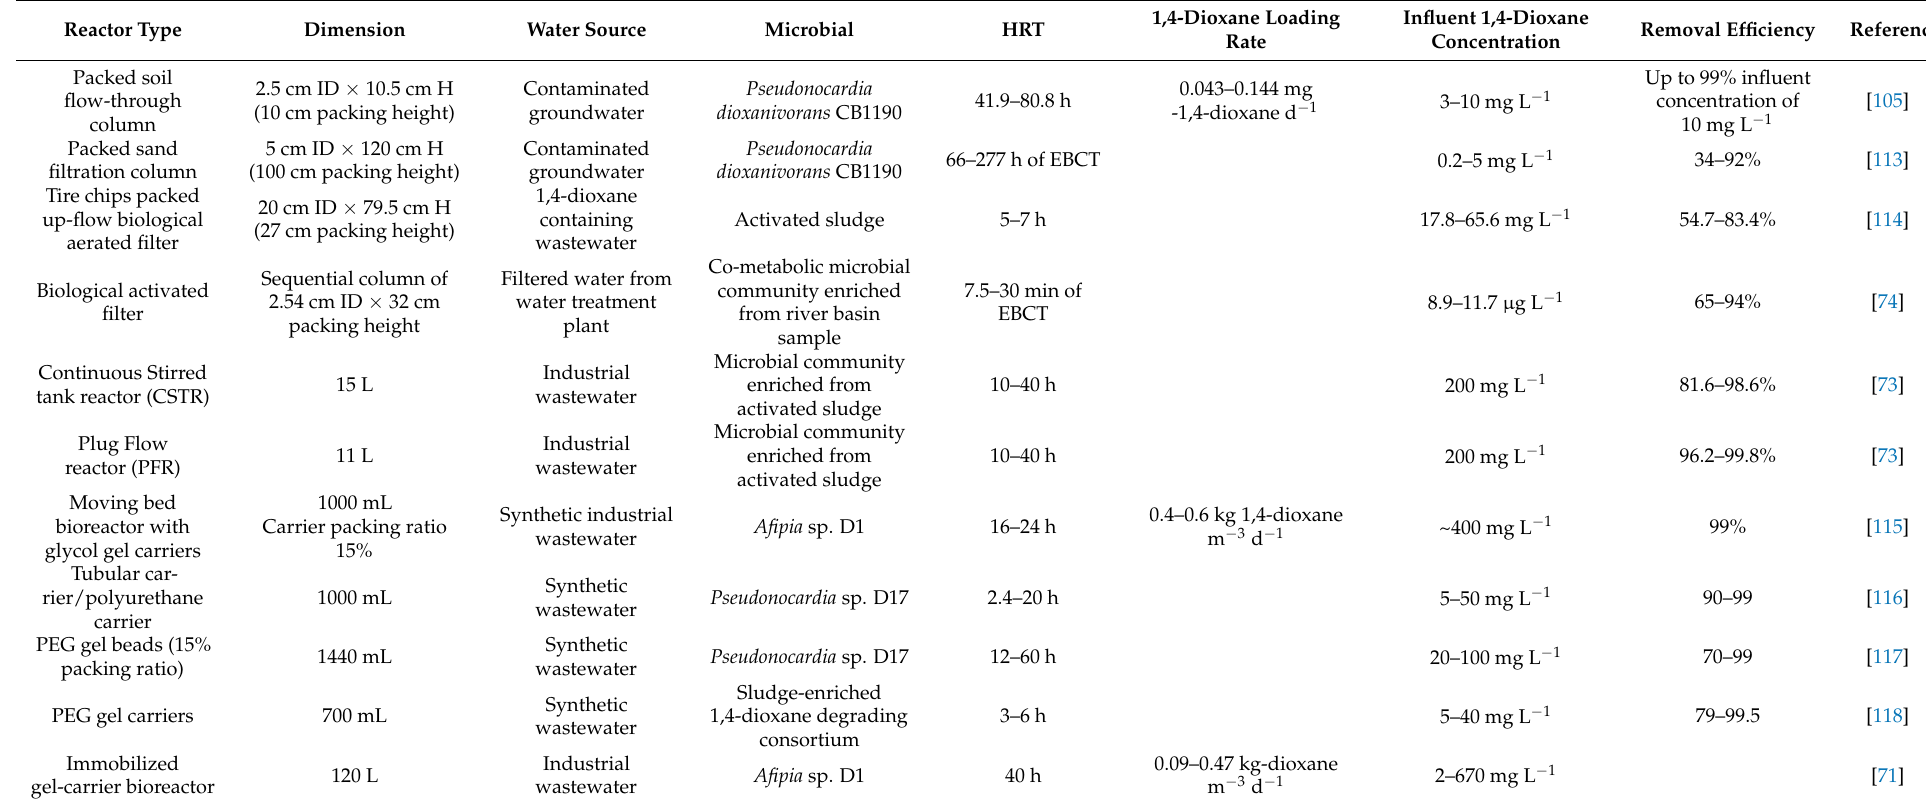
Table 4. Summary of reported bioreactor for 1,4-dioxane